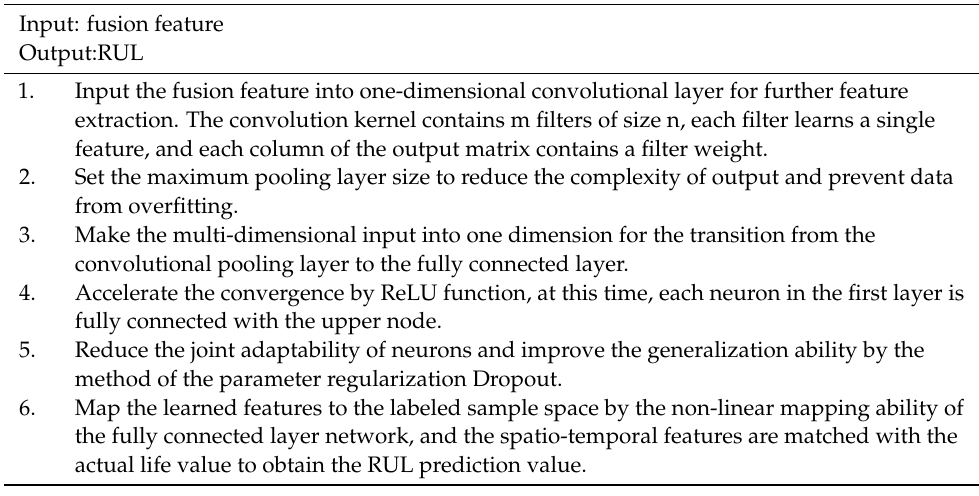
Algorithm 2 RUL Prediction Algorithm